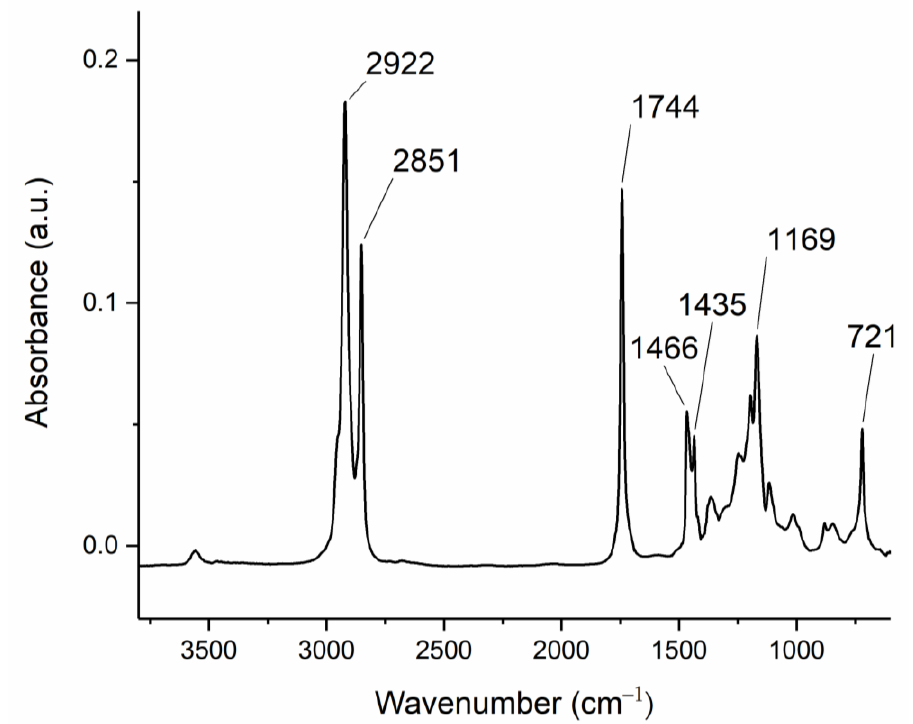
Figure 7. FT-IR spectrum for hydrogenated canola FAME.